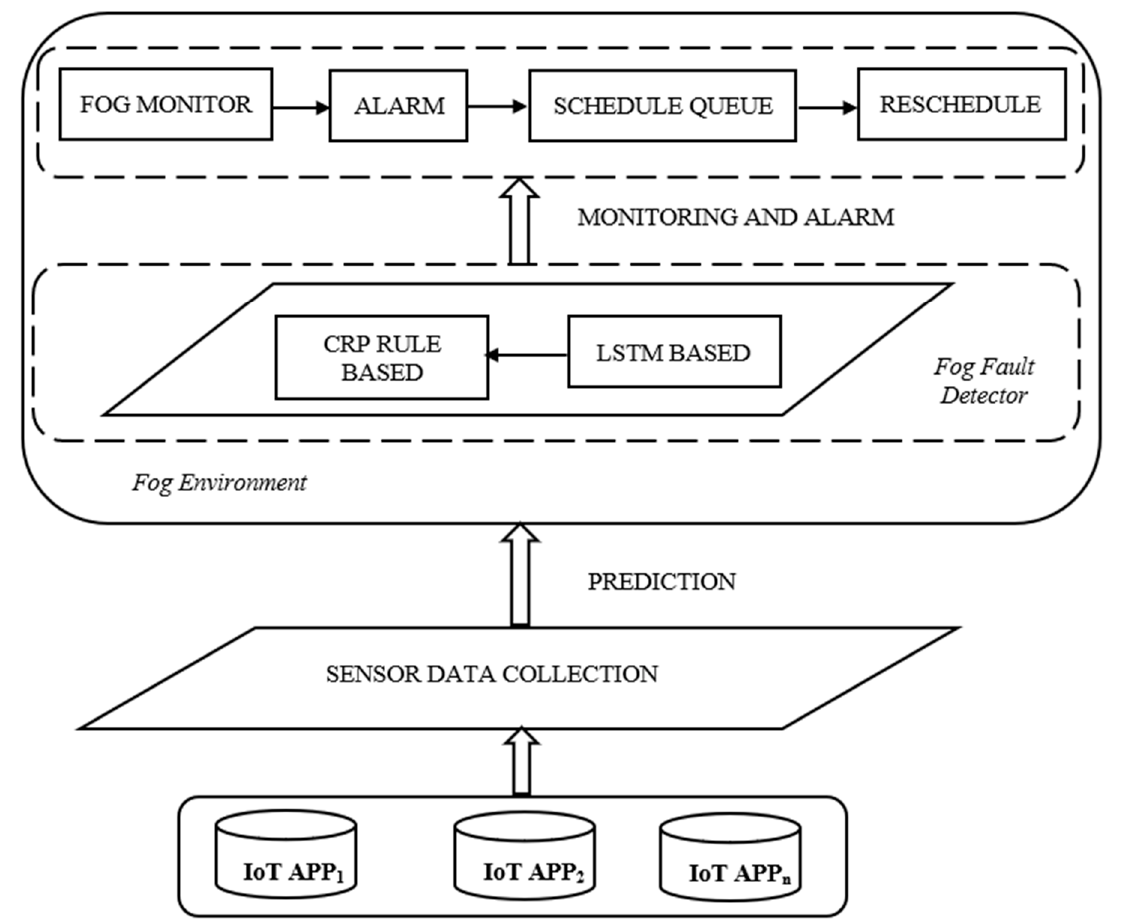
Figure 1. Overall architecture of the LSTM + CRP proposed framework.